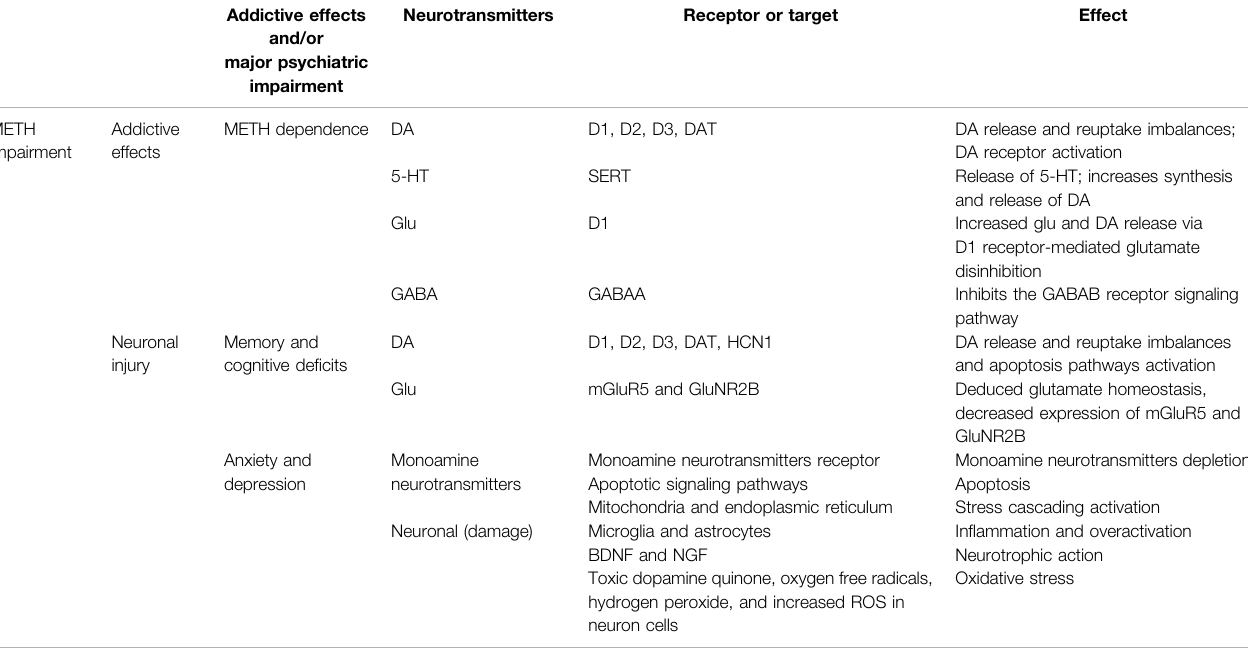
TABLE 1 | The effect of METH on neurotransmitters, their addictive effects, and/or psychiatric